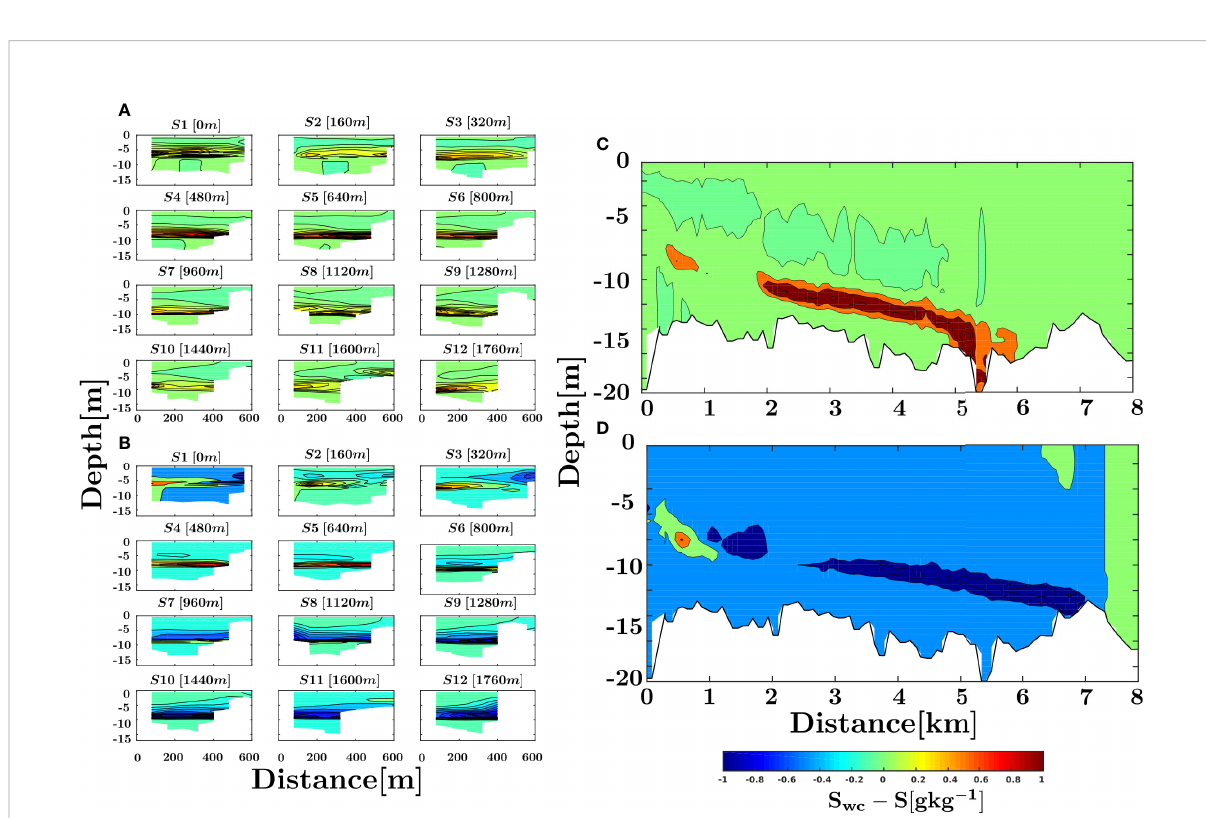
FIGURE 11 Differences in the transversal (A, B) and longitudinal (C, D) salinity distribution, with and without waves interaction, averaged over the spring tidal cycle, during the dry season of 2018 (A, C) and 2020 (B, D) .